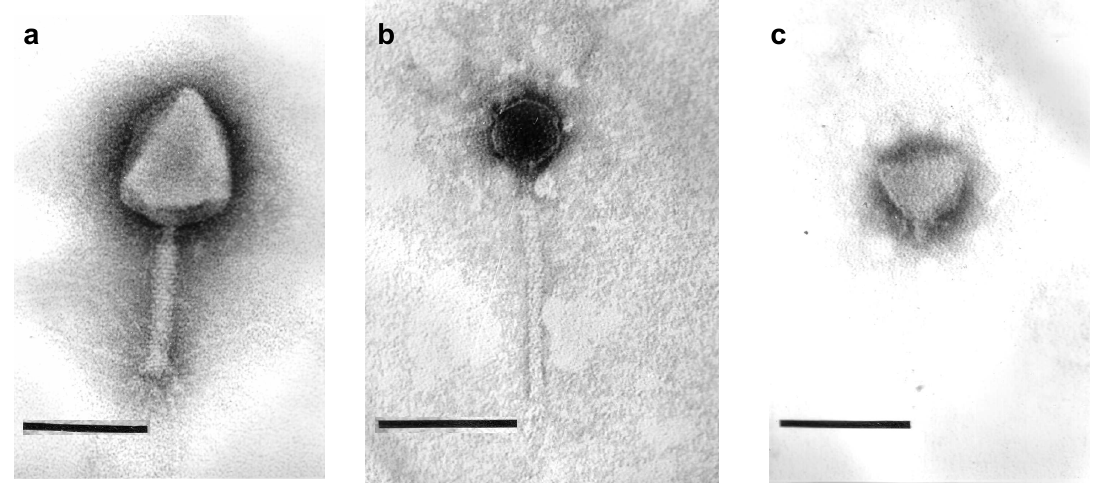
Figure 2. Negative staining of phages ACG-C91 ( a ); ACG-M12 ( b ) and ACG-C40 ( c ) with 2% uranyl acetate or 2% phosphotungstate. Final magnification is × 297,000. Bars indicate 100